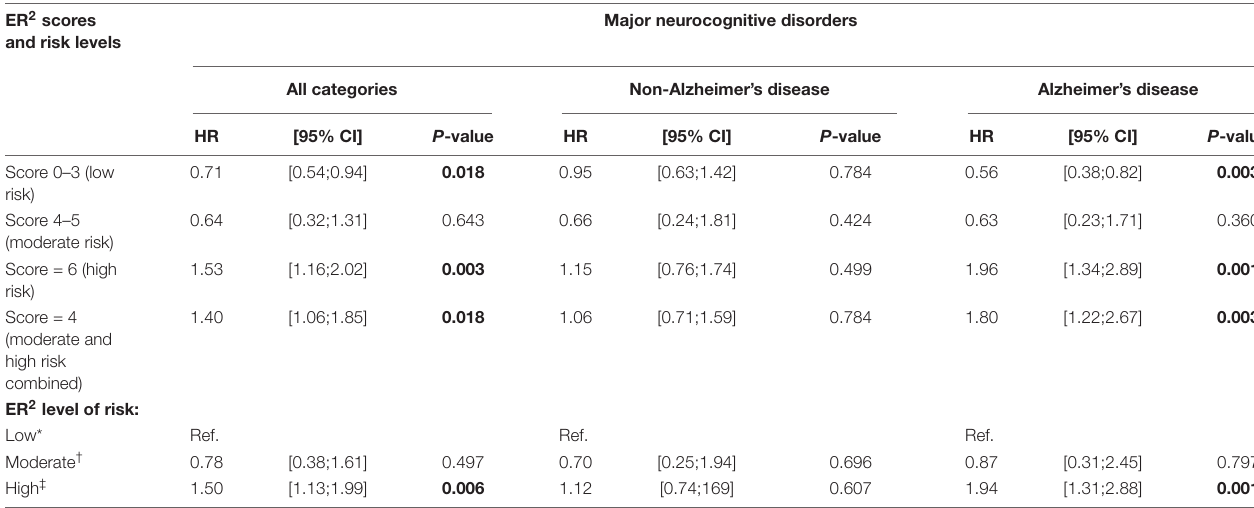
TABLE 2 | Cox regressions showing the association between ER 2 risk levels (independent variable; separated model for each risk level) and incident major neurocognitive disorders (all categories, non-Alzheimer’s disease, Alzheimer’s disease; dependent variable; separated model for each variable) in EPIDOS participants ( n =